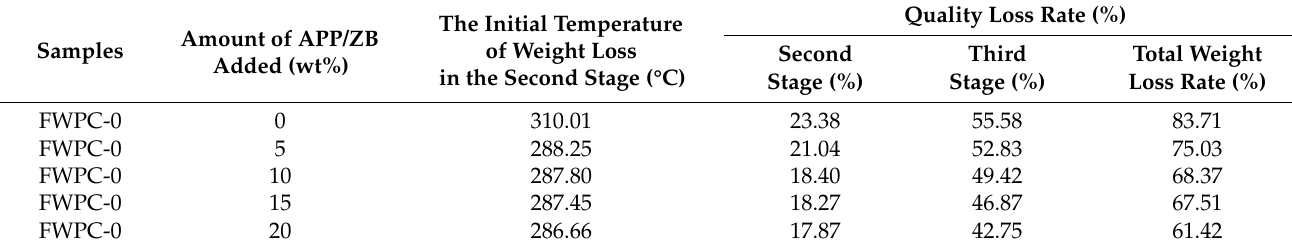
Table 3. Characteristic values of TG